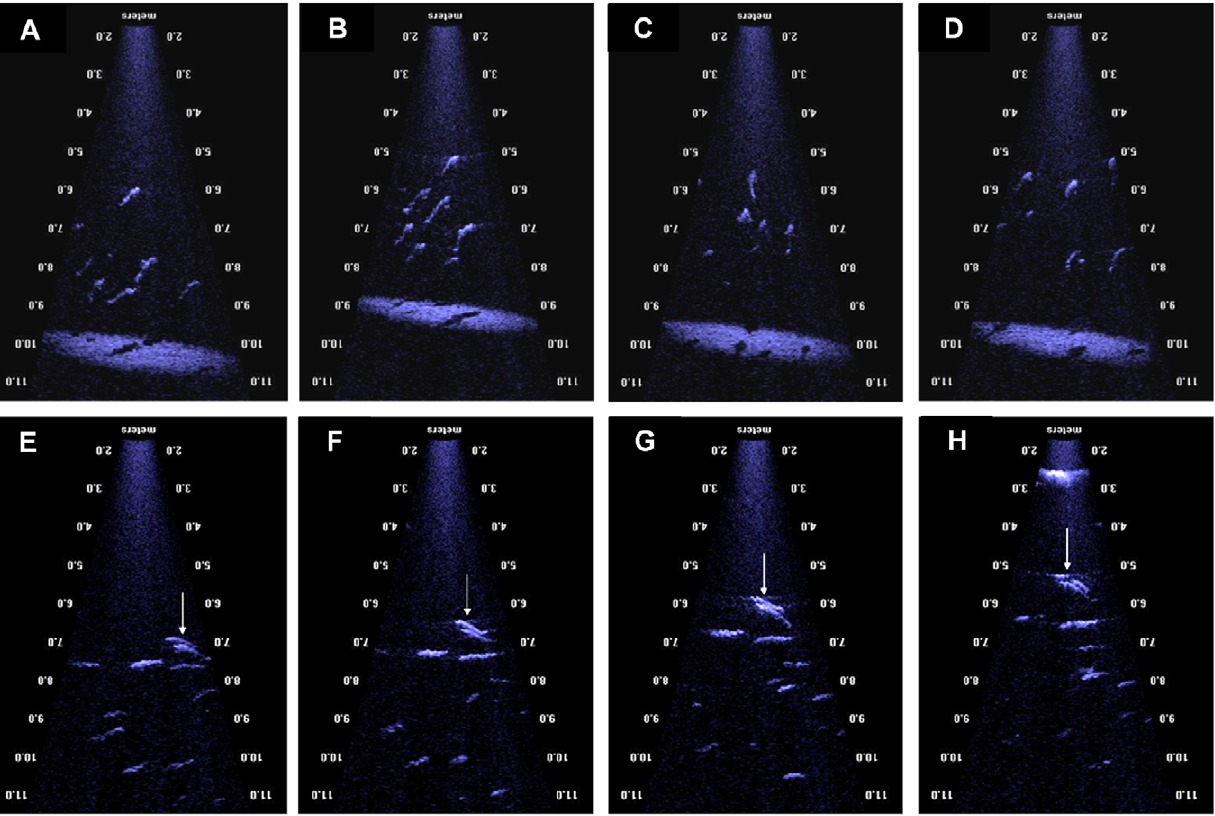
Figure 5. Images of Atlantic cod captured by a dual-frequency identification sonar (DIDSON) deployed approximately 1.0 km off the coast of Iceland at Knarraro´s on 15 April 2009. In panels a–d, the DIDSON is positioned approximately 10 m off the bottom and is oriented at a 30 u angle off perpendicular to the substrate. The Atlantic cod shown in these panels (a–d) are swimming up into the water column. The DIDSON is the same distance above the substrate in panels e–h, but oriented at approximately a 60 u angle to it. These cod seem to have reached the depth that the fish in panels a–d were ascending to and are swimming parallel to the substrate. Arrows indicate two individuals that may be coupling and engaged in a spawning event. The full video file from which these images were captured can be found in the supplementary information (Video S1).